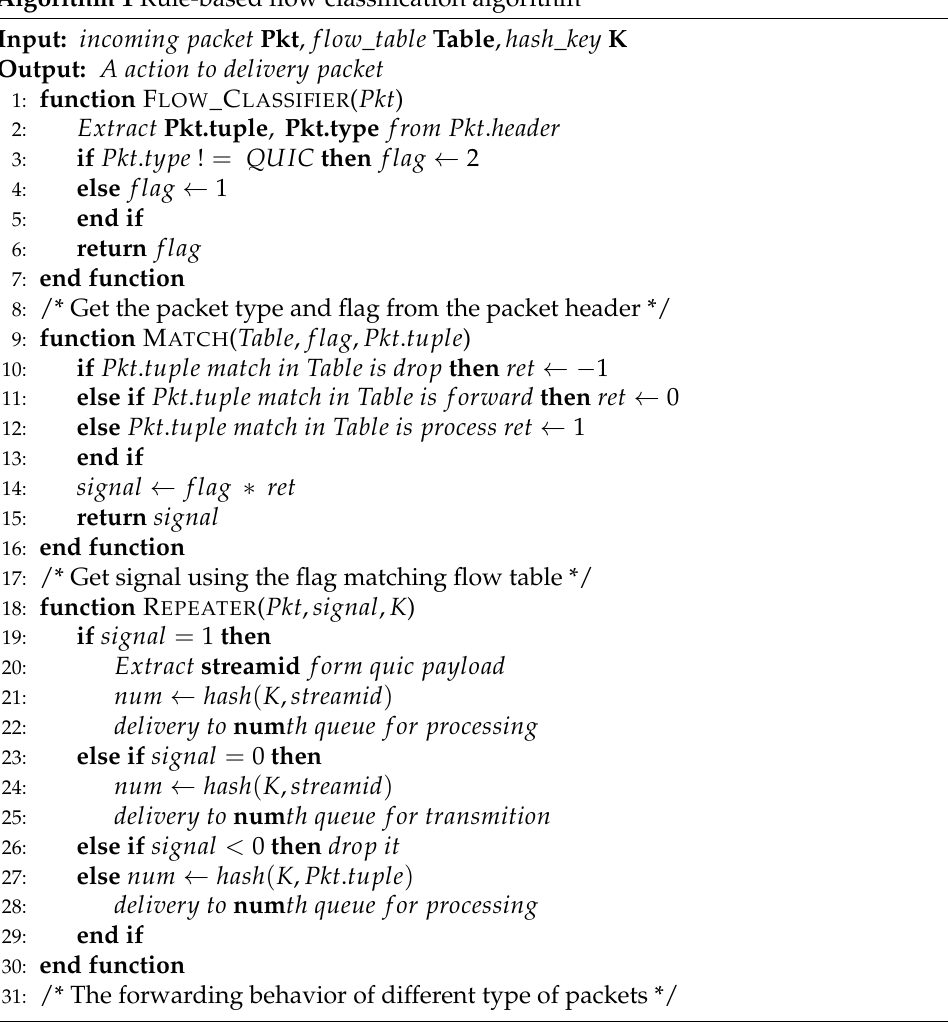
Algorithm 1 Rule-based flow classification algorithm